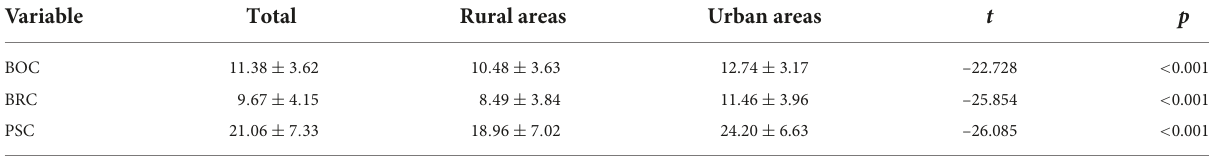
TABLE 2 Scores of personal social capital among older people (Mean ± SD). Variable